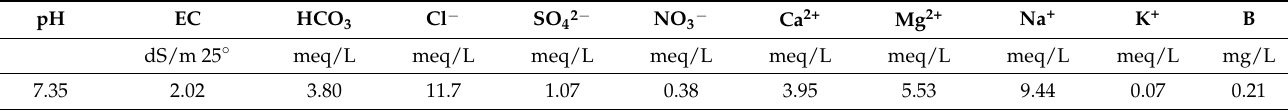
Table 1. Water irrigation analysis.